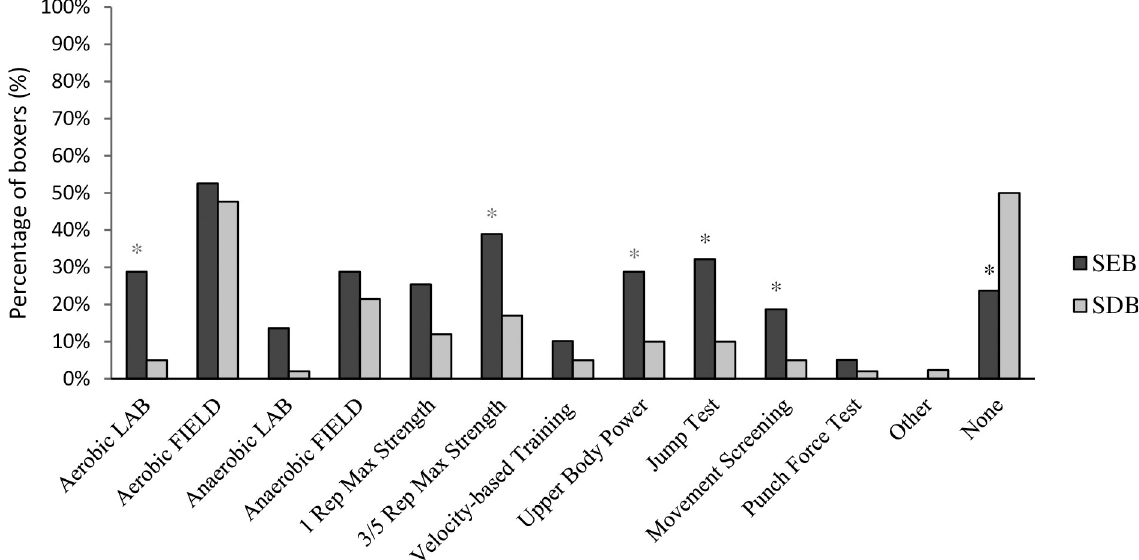
Fig 3. Percentage of boxers who regularly performed common physical fitness tests. � denotes a significant association between competitor level and the use of physical fitness tests (P � 0.005).